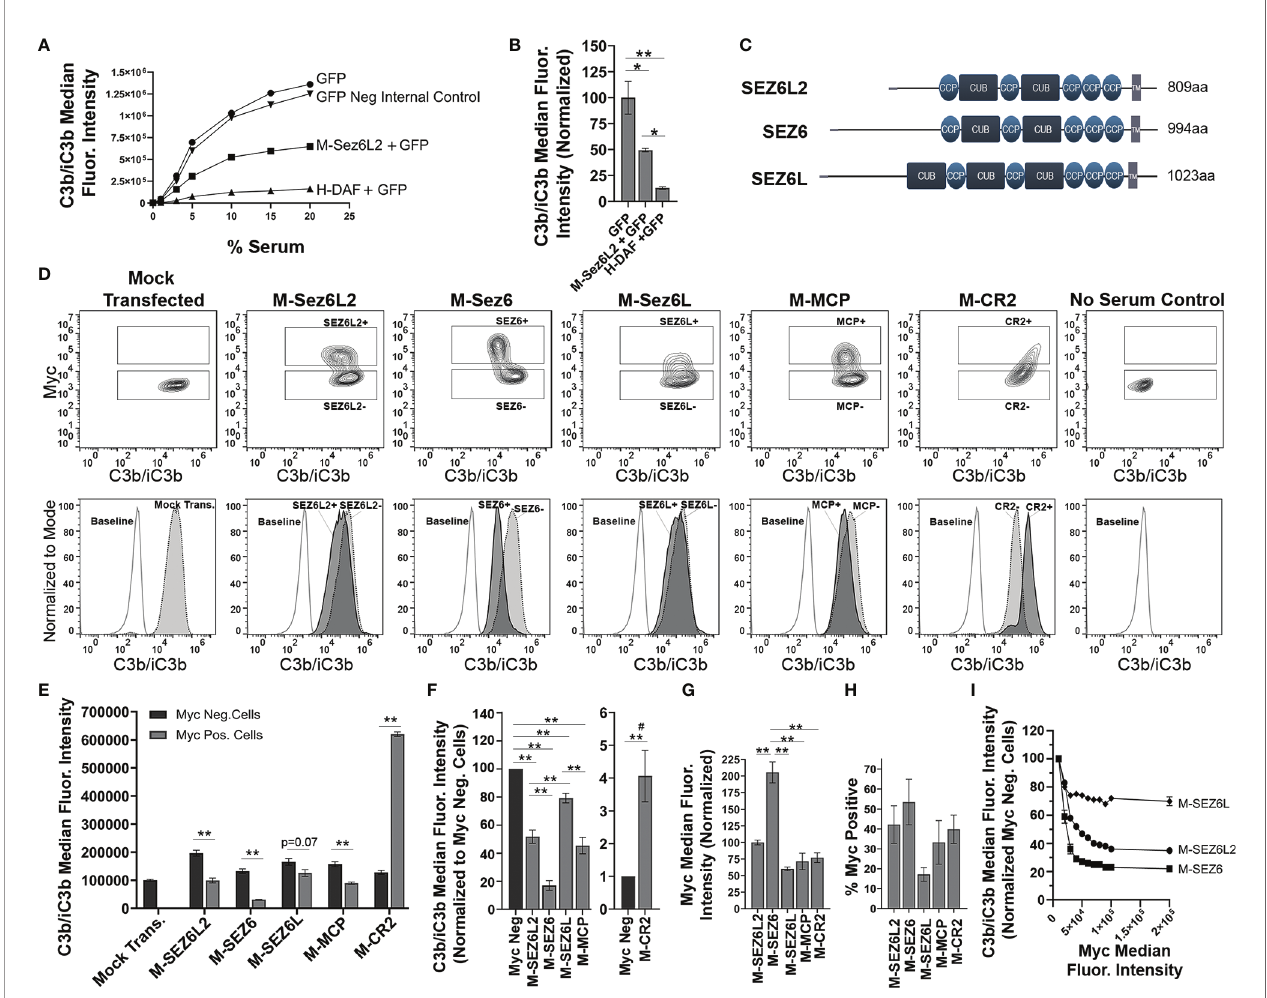
FIGURE 2 | Full Length Sez6L2, Sez6, and Sez6L inhibit C3b/iC3b opsonization of CHO cells by the classical pathway. (A, B) Sez6L2 inhibits C3b/iC3b opsonization at a range of serum concentrations. CHO cells were transfected with plasmids for GFP alone or with Myc-tagged Sez6L2 (M-Sez6L2) or His-tagged DAF (H-DAF). CHO cells were coated with antibodies and exposed to 0-20% C5-depleted human serum for one hour and then immuno-stained with anti-C3b/iC3b antibodies and analyzed by fl ow cytometry. One experiment is shown that is representative of two independent experiments. (B) C3b/iC3b on GFP transfected cells with or without M-Sez6L2 or H-DAF at 15% serum. ANOVA (P=0.0016; F(2,6)=22.51). N=3; one experiment with three replicates (representative of 3+ independent experiments). (C) Schematic of Sez6L2, Sez6, and Sez6L protein domain structures. (D – I) CHO cells were transfected with the indicated Myc-tagged cDNAs and processed as outlined in A with 15% C5 depleted serum, except that an anti-Myc antibody was used in place of GFP to identify transfected and expressing CHO cells. (D) 5% Contour plots of C3b/iC3b versus Myc fl uorescence (top layer) and C3b/iC3b fl uorescence histograms (bottom layer) of the same samples normalized to mode and compared to baseline cells not exposed to serum. For Contour plots, boxed regions highlight cells designated as Myc-positive (top box) and Myc- negative (lower box) populations. For C3b/iC3b histograms, dark grey, solid line population = Myc-positive cells; Light grey, dotted line population= Myc-negative cells; White, dashed grey line population = baseline. Representative of 4+ independent experiments. (E) Quanti fi cation of the average median C3b/iC3b fl uorescence intensity from Myc-positive and Myc-negative cells within each sample. Statistics = t-tests. N=3 (one experiment with three replicates; Representative of 4+ independent experiments). (F) Average median C3b/iC3b fl uorescence intensities after normalization to the Myc-negative cells from each experimental group. ANOVA between Myc-positive cell populations (p<0.001; F(4, 15)=64.53). Sez6L2 inhibits C3b/iC3b opsonization at a level comparable to positive control MCP. Sez6 is a stronger complement inhibitor than Sez6L2 and Sez6L is a weaker inhibitor. (F) Average median Myc fl uorescence intensity from Myc-positive cells. ANOVA (p<0.001; F(4, 15)=36.79). (G) Average % of Myc-positive cells in each experimental group (ANOVA, p=0.115; F(4, 15)=2.224). For sections (F – H) , N=4 (four independent experiments). (I) Sez6 blocks complement opsonization more ef fi ciently than Sez6L2 and Sez6L even when comparing similar levels of Myc surface expression. Average C3b/iC3b median fl uorescence intensity normalized to internal Myc-negative populations for M-Sez6, M-Sez6L2, and M-Sez6L samples shown relative to the Myc median fl uorescence intensity. N=3 (one experiment with three replicates, Representative of three independent experiments). For all graphs *p < 0.05; **p < 0.01; # p < 0.001 for all Myc-positive groups compared to